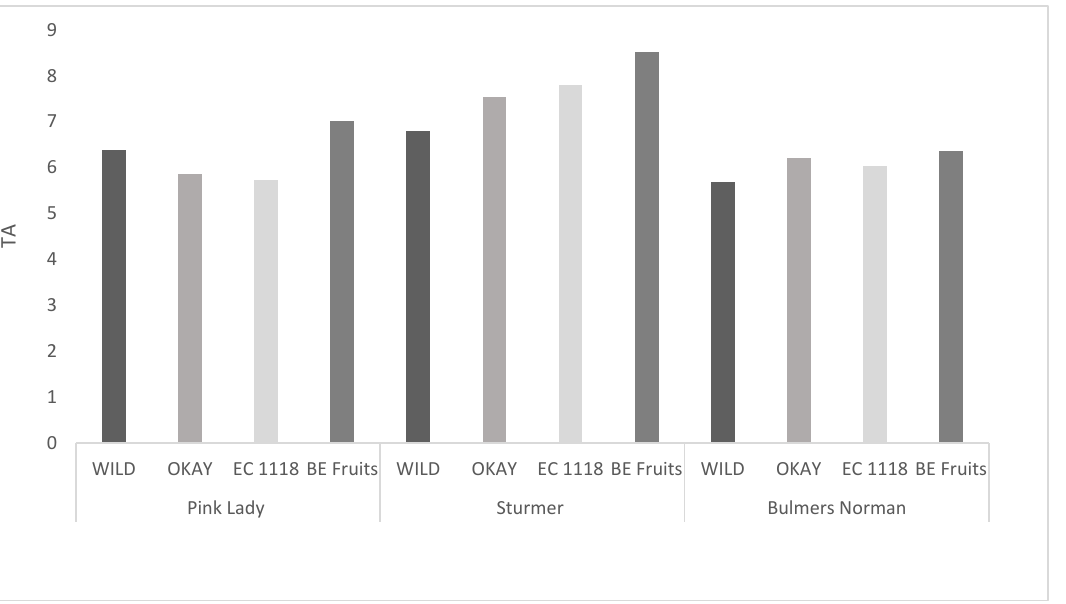
Figure 1. Titratable Acidity (TA) of cider made with each yeast strain for all three apple varieties in